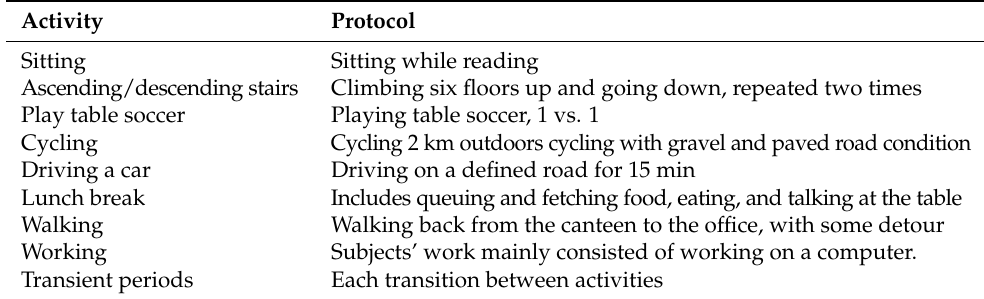
Table 1. Type of activities and detailed protocol based on the study of Reiss et al. [32].